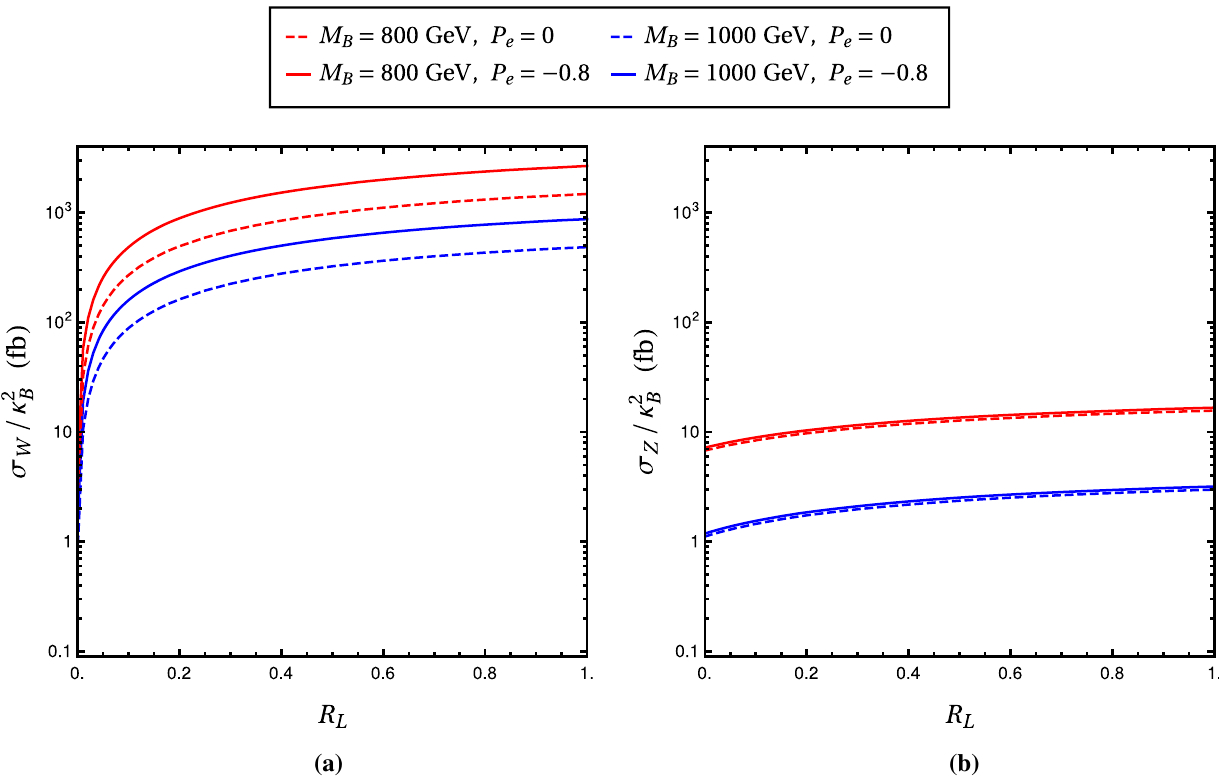
Fig. 4 The scaled cross sections of the processes e − p → W → ν B and e − p → Z → e − B as functions of R of e − beam